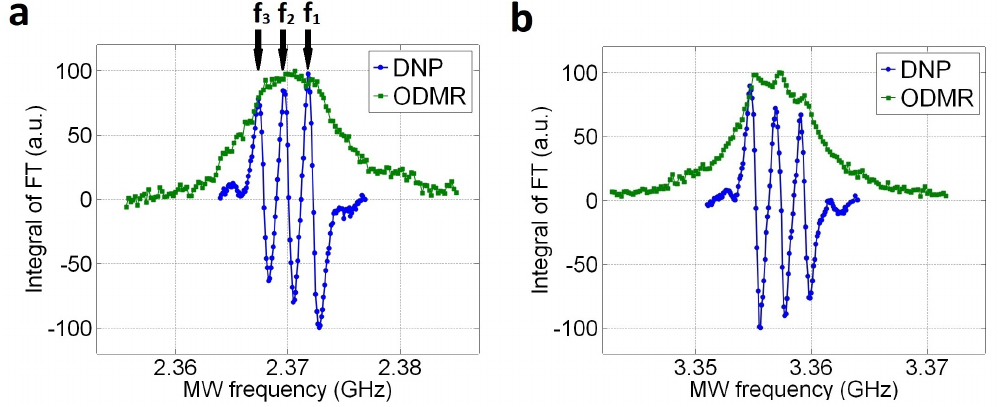
Figure 2. Normalized values of integrated Fourier Transform (FT) signals (blue line) and ODMR signal (green line) are plotted as a function of the MW frequency at 17.6 mT for the transitions of m s = 0 → m s = − 1 ( a ) and m s = 0 → m s = +1 ( b ). Each data point for each MW frequency is measured with the same experimental